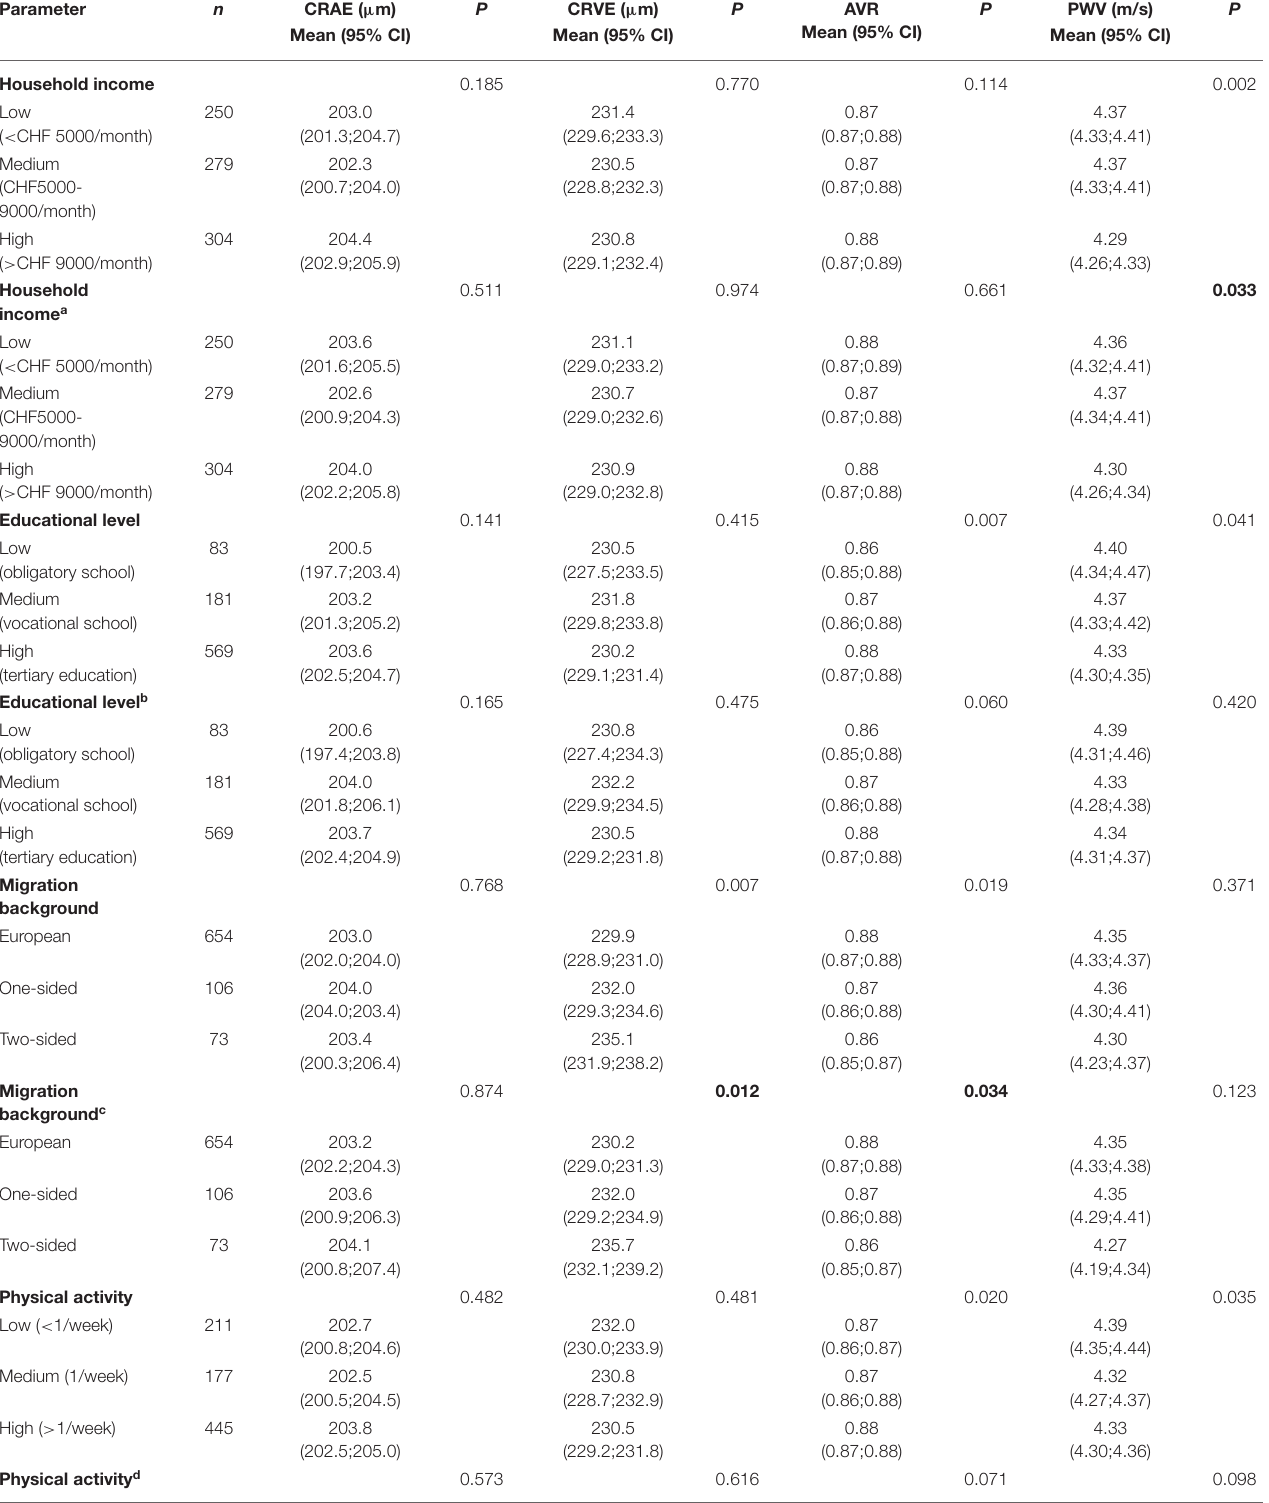
TABLE 2 | Retinal vessel diameters and pulse wave velocity in relation to categories of household income, education level, migration background, parental smoking and physical activity behavior.